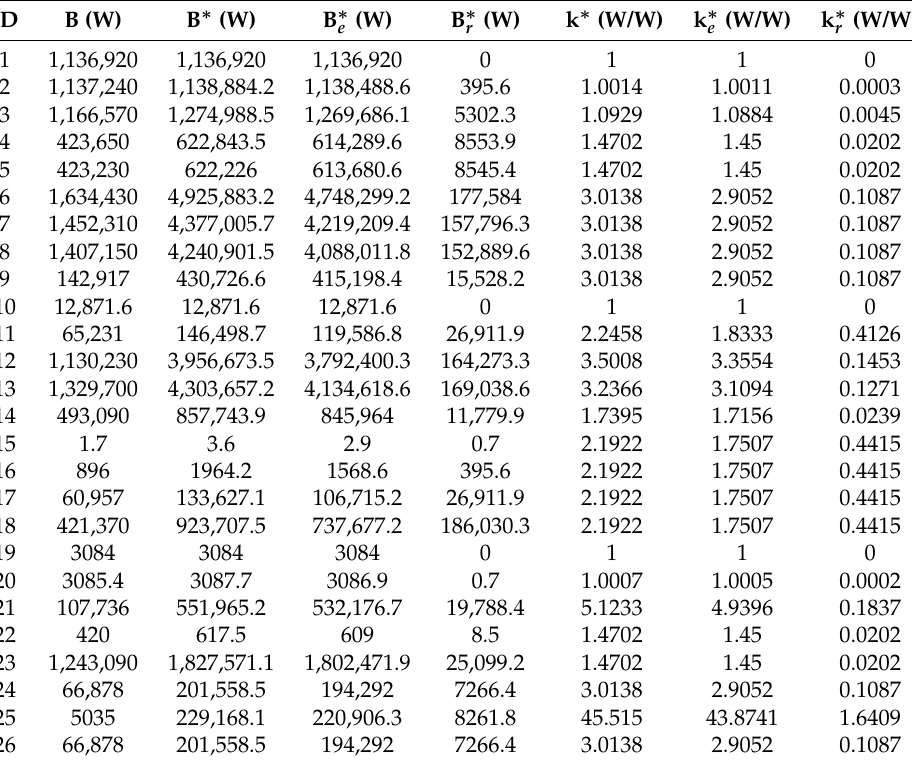
Table 6. Exergy costs of the flows part of the SOFC-VAR